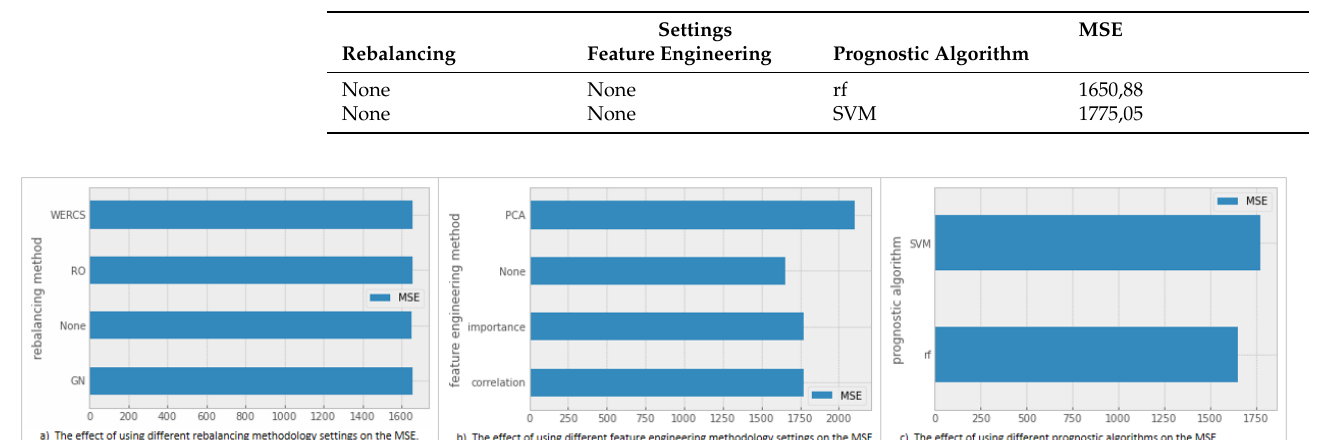
Table 11. A comparison of applying the different prognostic algorithms and the resulting MSEs on dataset FD001.